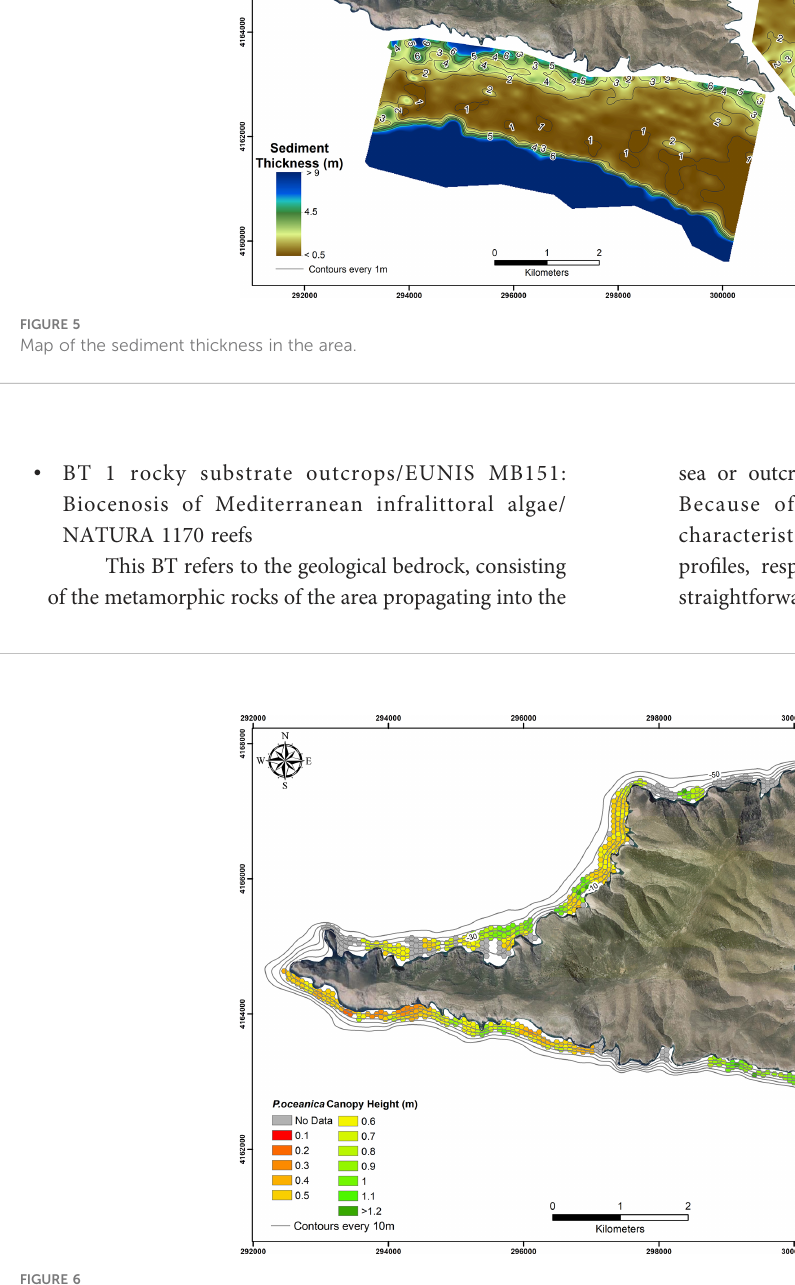
FIGURE 6 Map of P. oceanica canopy height and distribution.